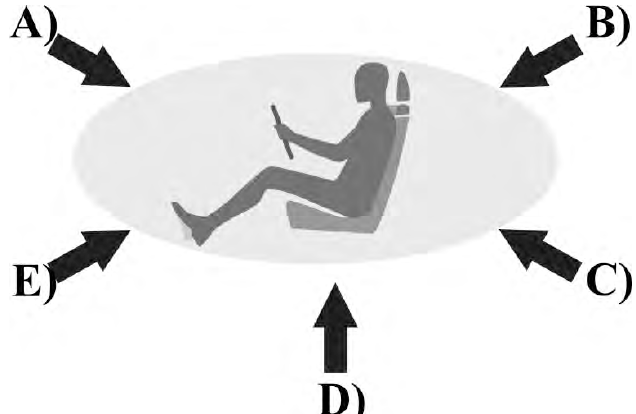
Fig. 2. Harmful production factors of the environment that have an impact on the health of drivers of route buses [4, 5]: A) - Noise; B) - Nervous-emotional stress; C) - Harmful substances; D) - Unfavorable microclimate of the working environment; E) -